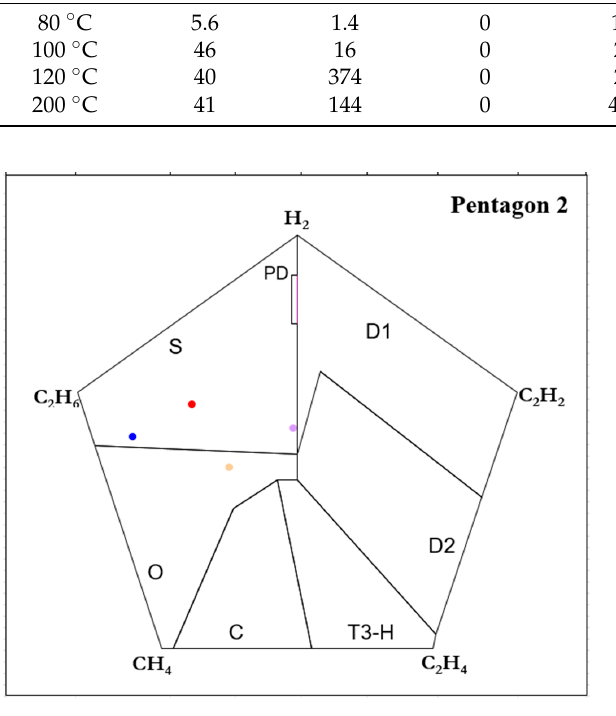
Figure 5. SG patterns of DDB oil during SG tests at 80 °C to 200 °C in the laboratory.